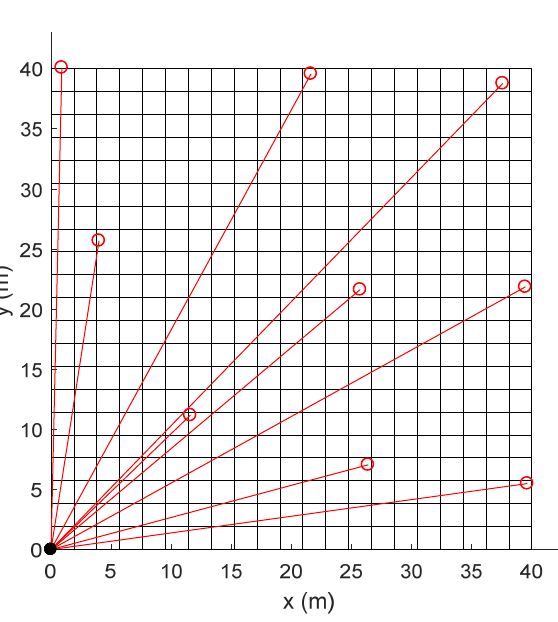
Figure 3. Grid division (21 × 21) of the site for tomographic reconstruction.